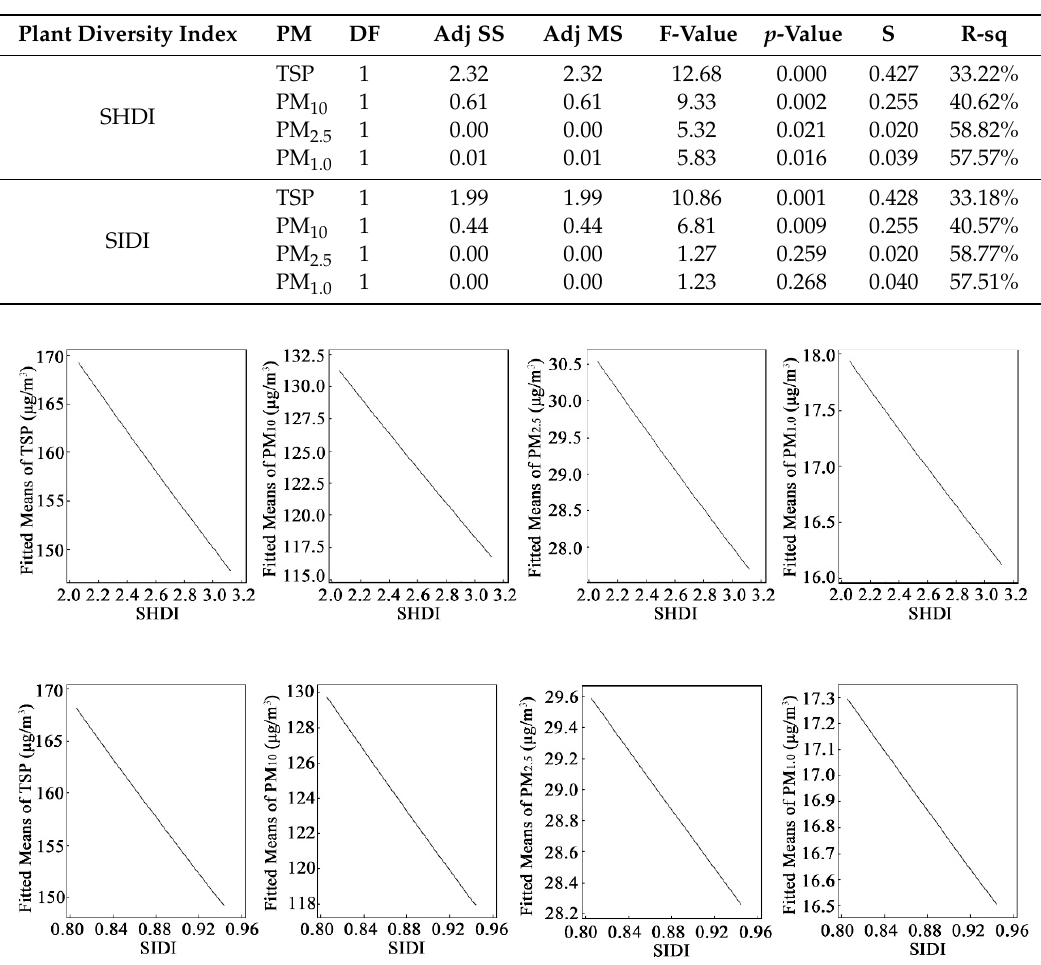
Table 8. Linear regression analysis of plant diversity index and atmospheric suspended particulate matter concentration.